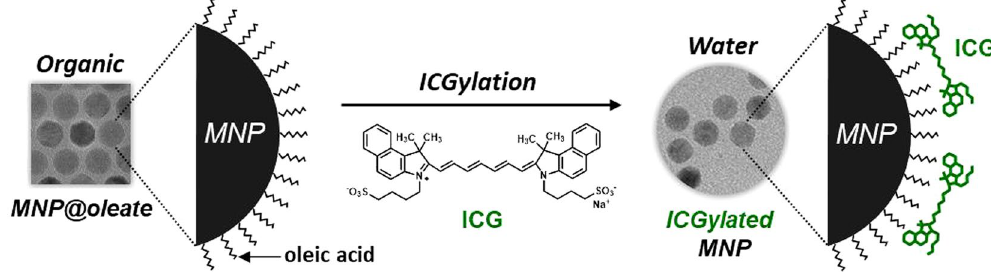
Figure 1. Schematic illustration of preparation of ICGylated MNPs. Hydrophobic magnetic nanoparticles (MNPs) were coated with indocyanine green (ICG) molecules, which enable their phase transfer to aqueous